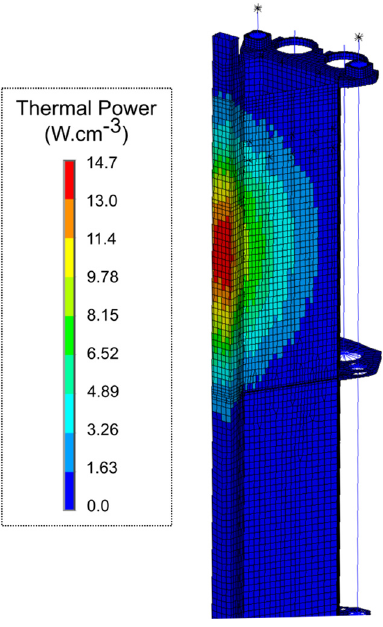
Fig. 13. Thermal power due to irradiation on P5 sector.